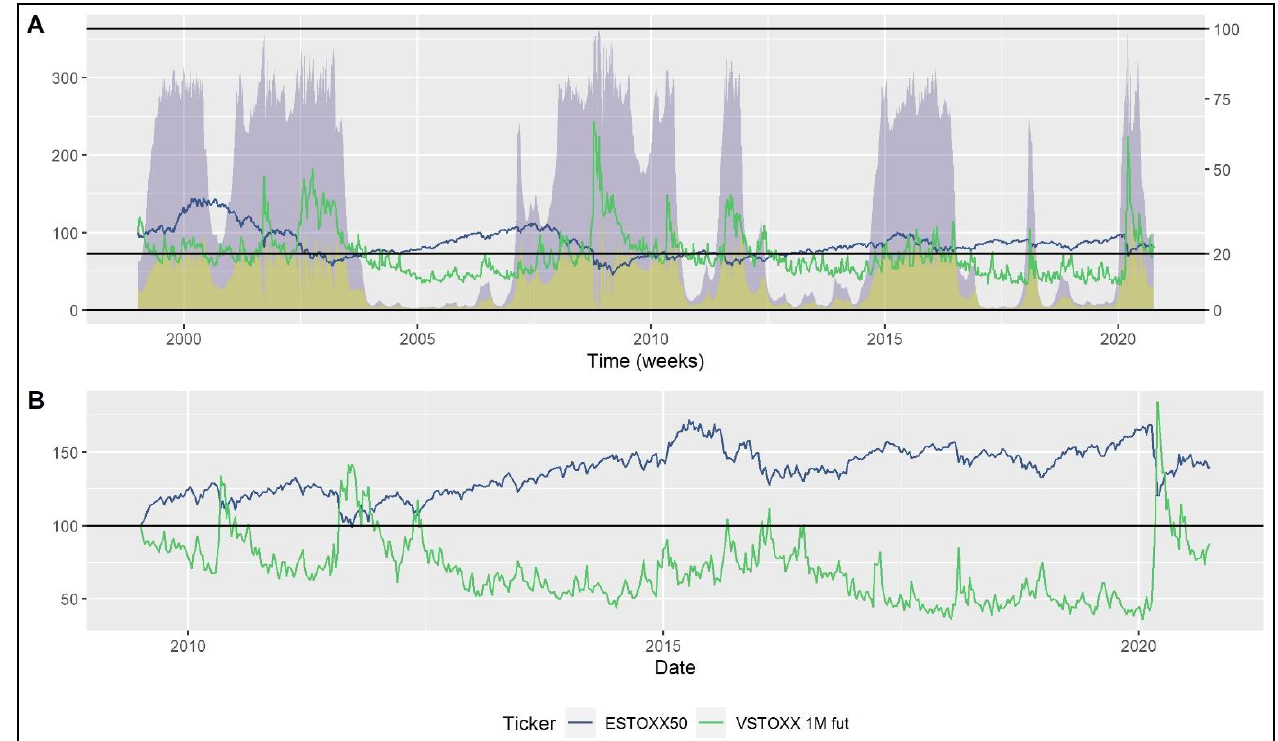
Figure 1. Weekly historical performance of the ESTOXX50 stock index, the VSTOXX index, and the VSTOXX one-month future contract. ( A ) It presents the historical 8 August 2021 Base 100 value of the ESTOXX50, the VSTOXX value (right axis), and the high (s = 2) and extreme (s = 3) smoothed probabilities at 𝑡 ; ( B ) The 3 July 20201 Base 100 value of the performance of a “buy-and-hold” investment strategy in the ESTOXX50 stock index and the one-month VSTOXX future contract.